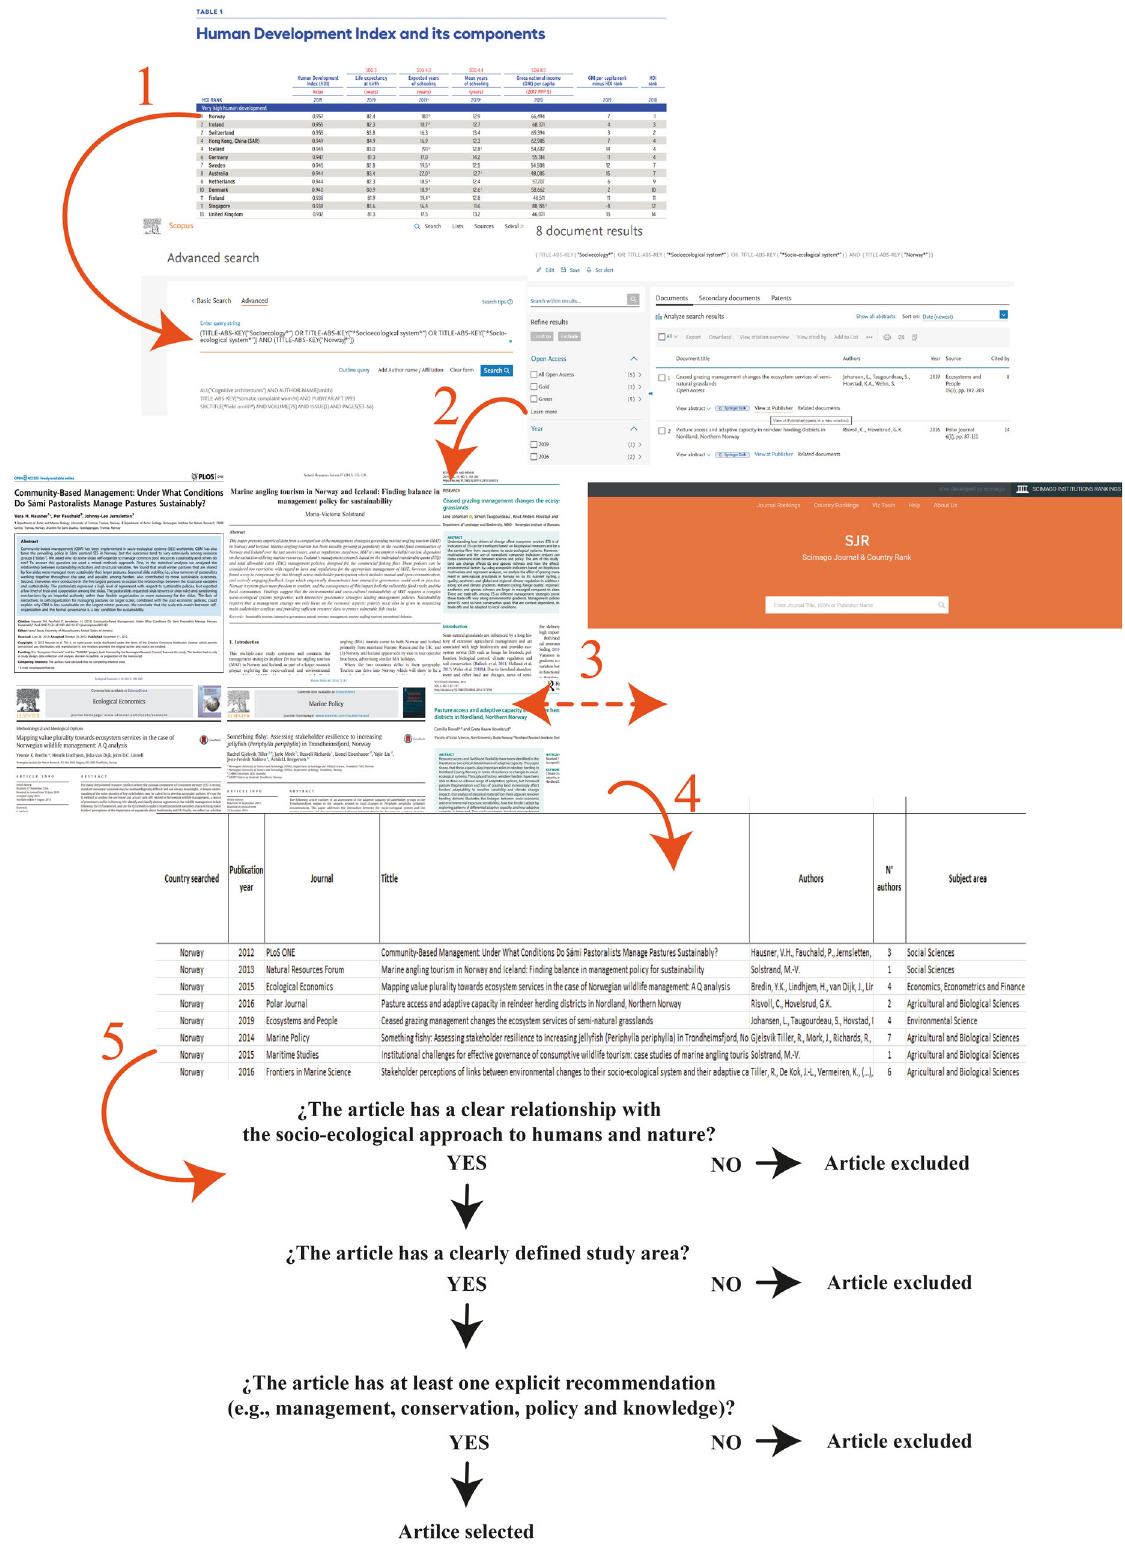
Fig. 1 A diagram depicting how the papers chosen for review were selected. The numbers indicate each stage for the inclusion and exclusion of articles. 1 = selection of countries based on the Human Development Index (HDI); 2 = searching in Scopus (https://www.scopus.com/) for the articles of the selected countries based on the HDI (https://hdr.undp.org/); 3 = download of articles, analysis and review of their content, and identi fi cation of the research category based on Scimago (https://www.scimagojr.com/); 4 and 5 = tabulation of general information and evaluation of its relevance.